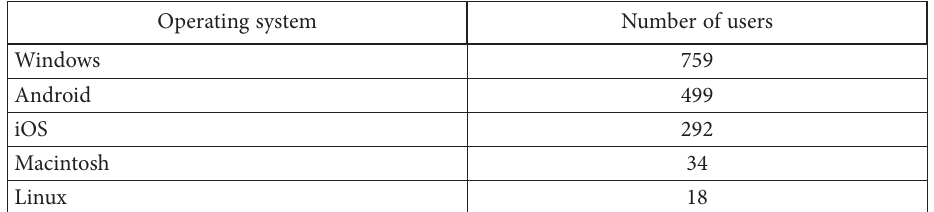
Table 4. Number of users by all operating systems (source: created by authors)